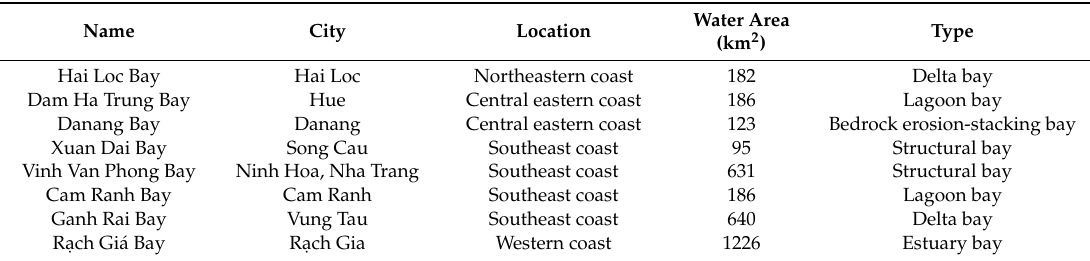
Table 2. Major bays along the coast of